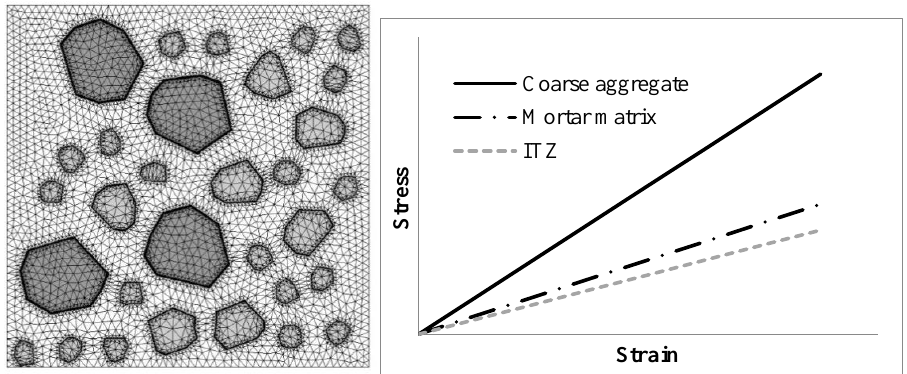
Figure 2: Micro components of concrete and its constitutive model